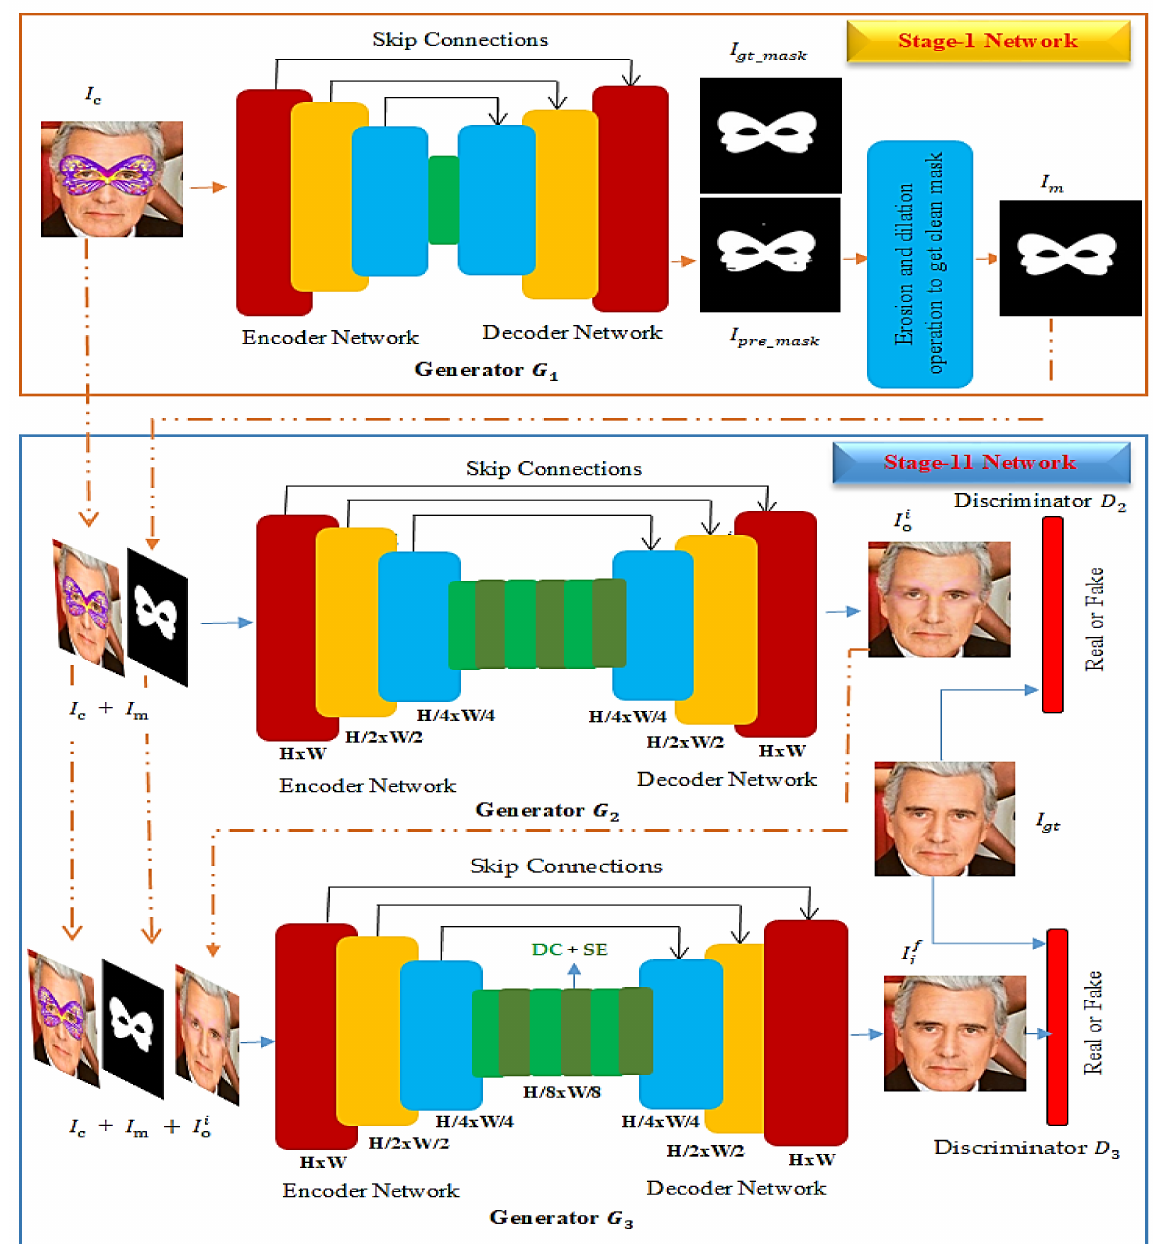
Figure 2. The architecture of the automatic mask removal network for face de-occlusion. It consists of Stage-I Network that generates a binary mask and Stage-II Network that removes the mask object from input facial